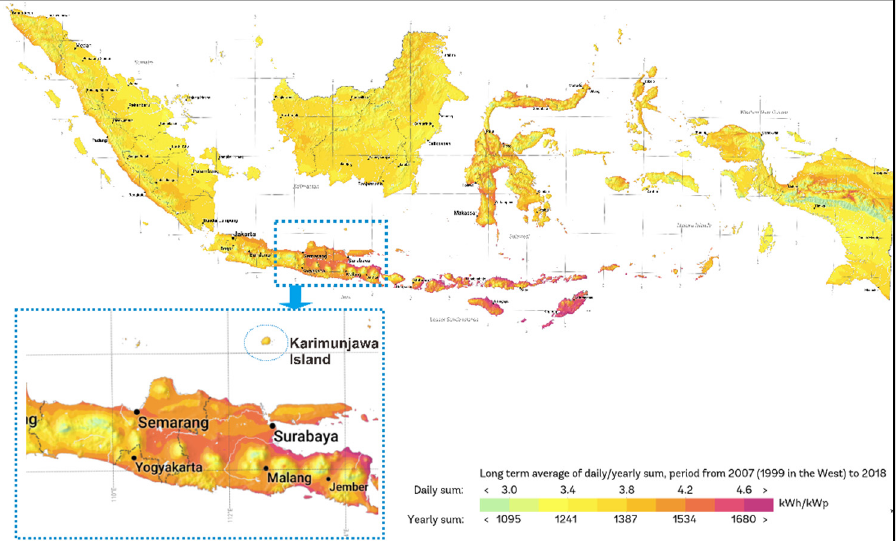
Table 2. IEC wind class standard [52].